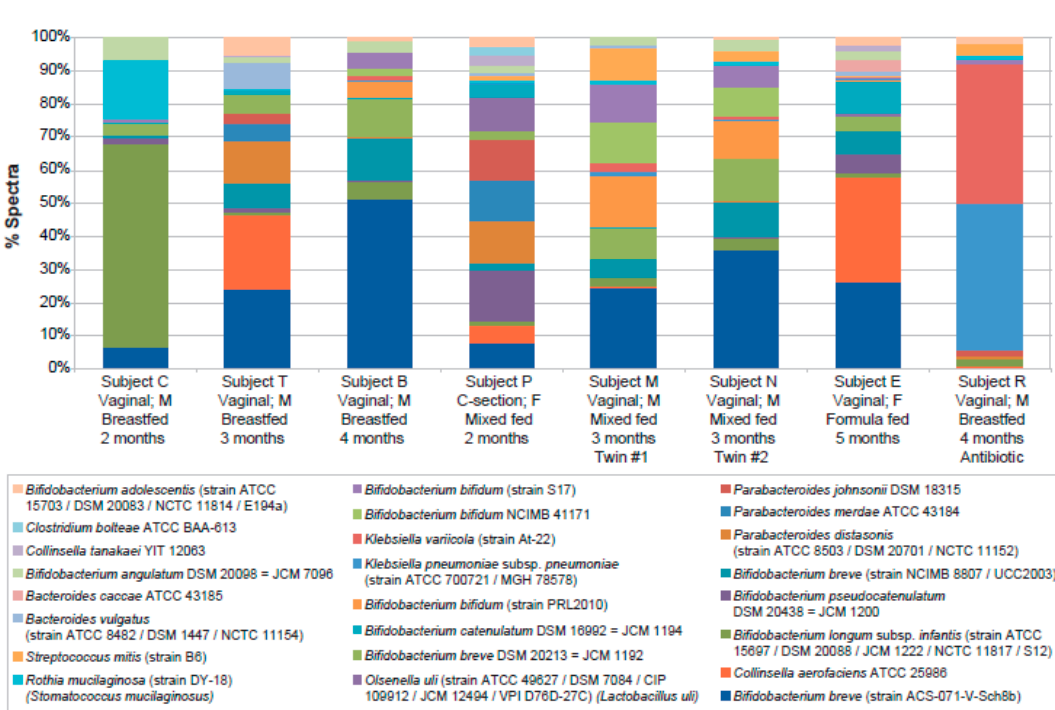
Total number of strains assigned with ≥ 1 unique spectrum 1